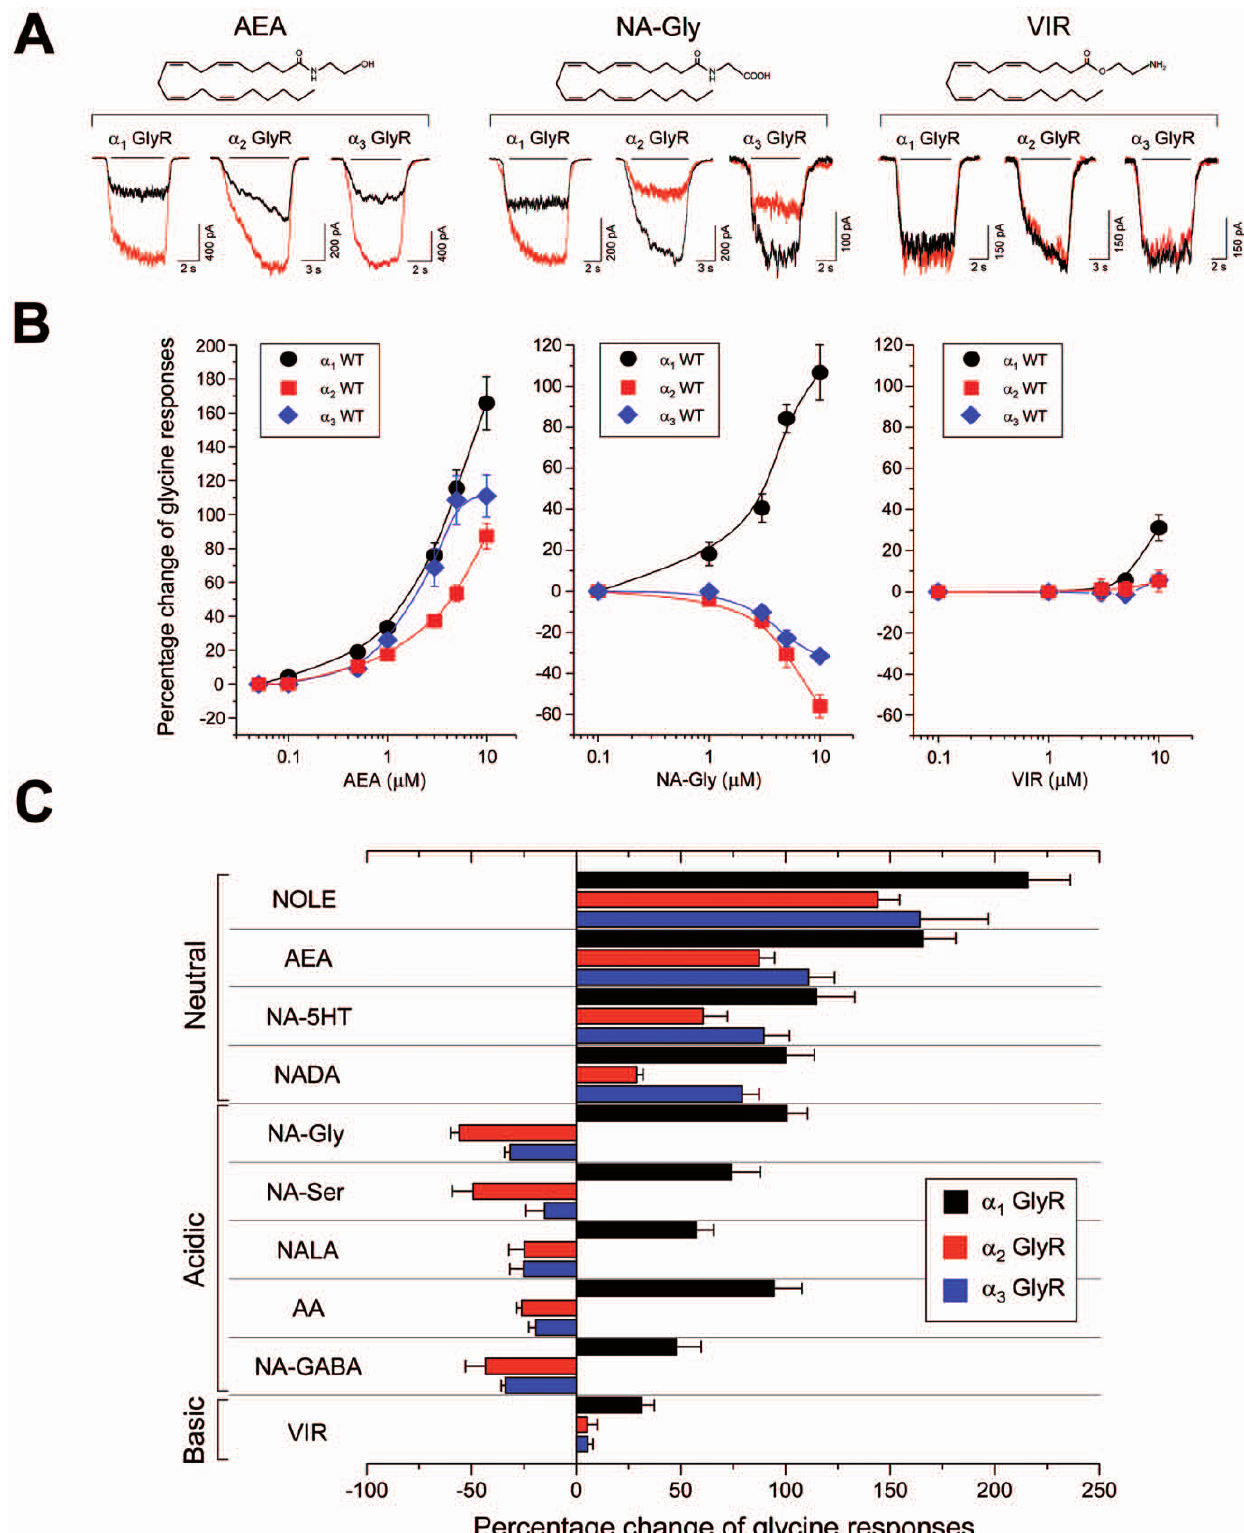
Figure 1. Modulation of different GlyR subtypes by ECs. ( A ) Glycine-activated membrane currents through wild-type a 1 , a 2 and a 3 GlyRs under control conditions (black) and in the presence of AEA, NA-Gly and VIR (red; all 10 m M). Membrane currents were activated by equipotent (EC 10 ) glycine concentrations for each particular subunit. Chemical structures for the ligands are also shown. ( B ) Concentration-response curves. ( C ) Summary of the EC-mediated allosteric modulation of GlyRs subunits obtained at 10 m M concentration. Note that all acidic ECs tested still potentiated the a 1 GlyR currents, but inhibited currents through a 2 - a 3 GlyRs. NOLE, noladin ether; AEA, anandamide; NA-5HT, arachidonyl serotonin;